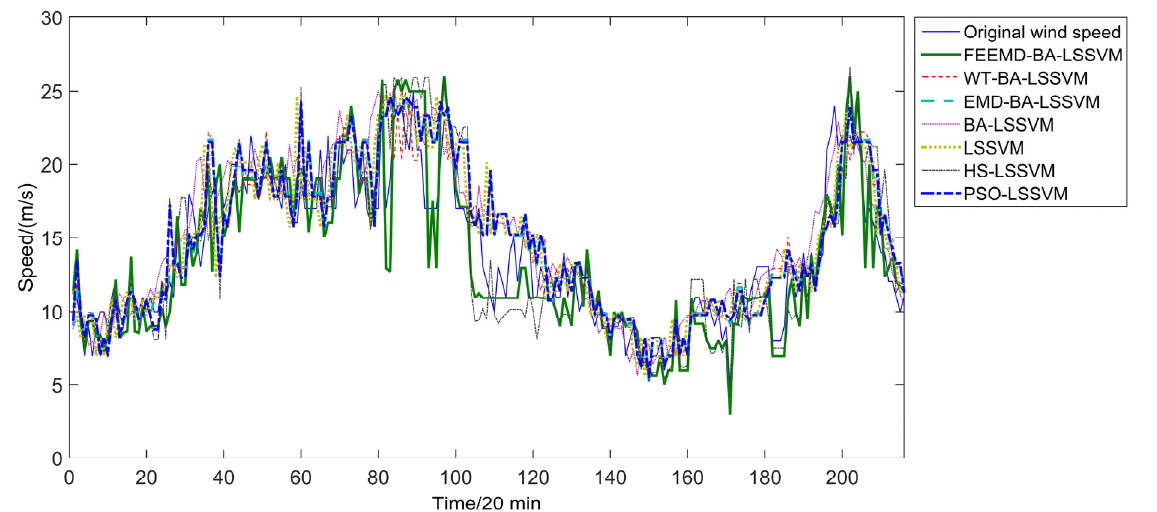
Figure 11. Forecasting results with temperature as